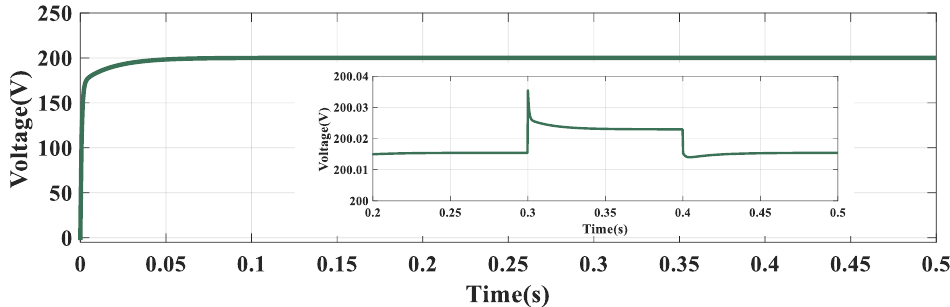
Figure 18. Study 3: load voltage.